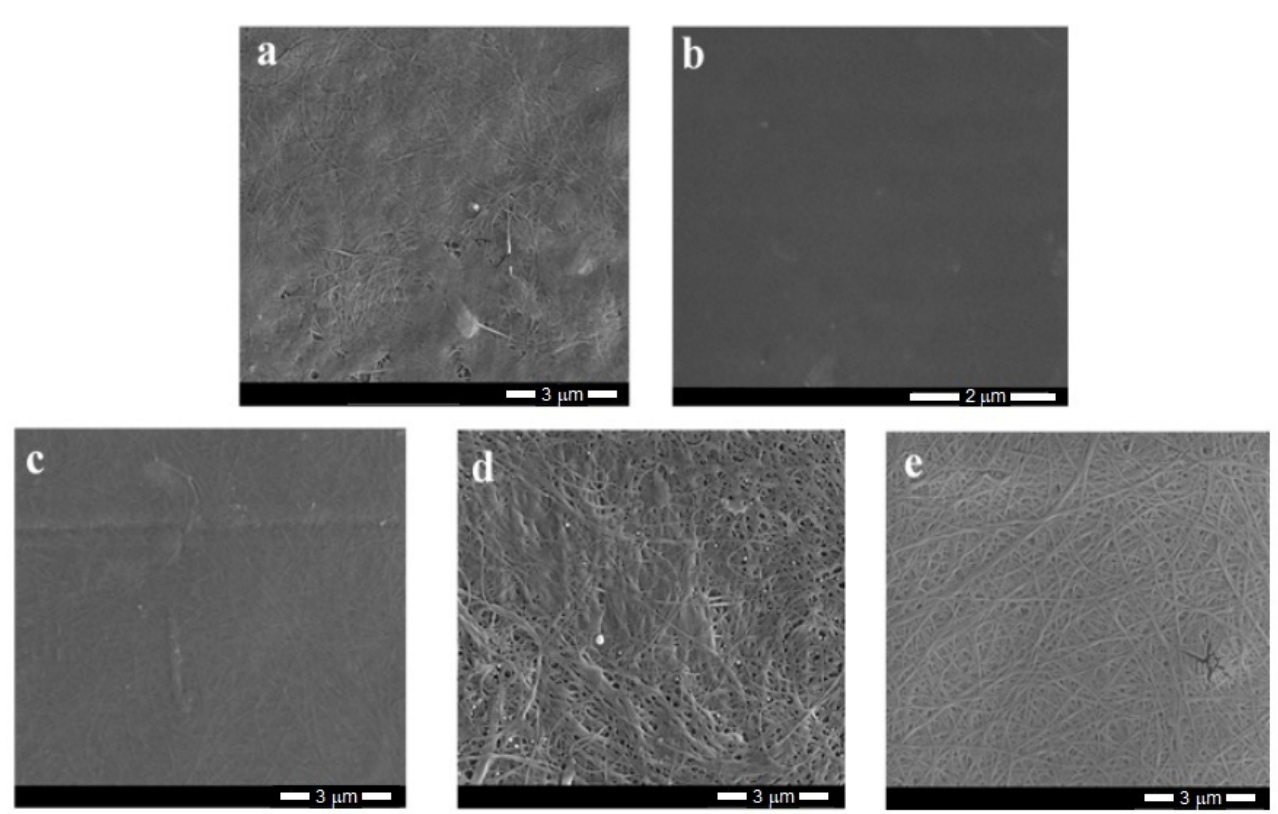
Figure 5. SEM images of BNC ( a ), PVA ( b ) and selected BNC/PVA composites (at 4% PVA) obtained by in-situ ( c ), ex-situ/impregnation ( d ), and ex-situ/sterilization ( e ); magnification 50,000 × . The scale bar is equal to 3 µ m; for PVA (picture b), it is 2 µ m.